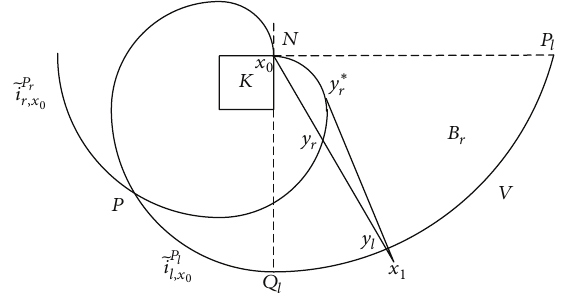
Figure 4: The regions 𝑁 , 𝐵 𝑟 , and 𝑉 when 𝐾 is a